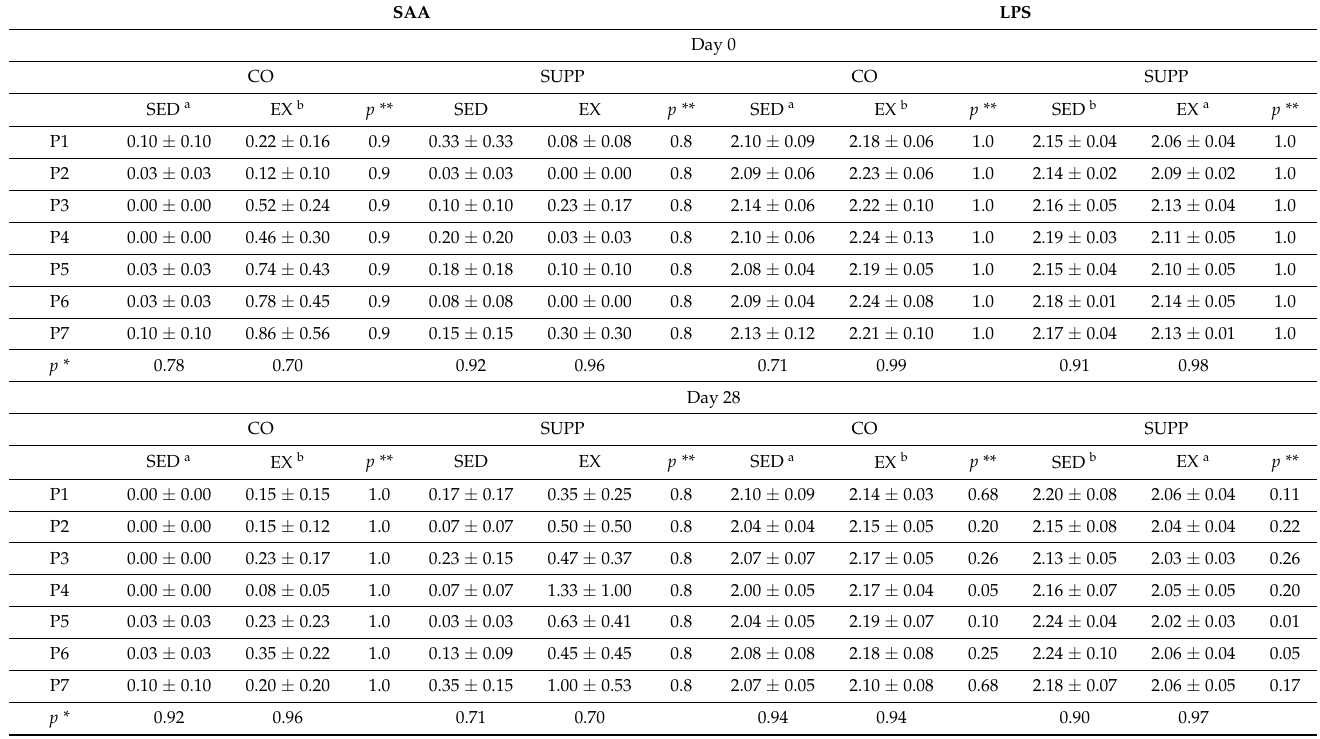
Table 2. Serum amyloid A (SAA; ug/mL ± SEM) and Lipopolysaccharide (LPS; pg/mL ± SEM) in horses challenged with combined transport and exercise (EX) or maintained as unchallenged controls (SED), before (Day 0) or 28 days after (Day 28) receiving a diet containing an Aspergillus oryzae prebiotic (SUPP) or a control diet